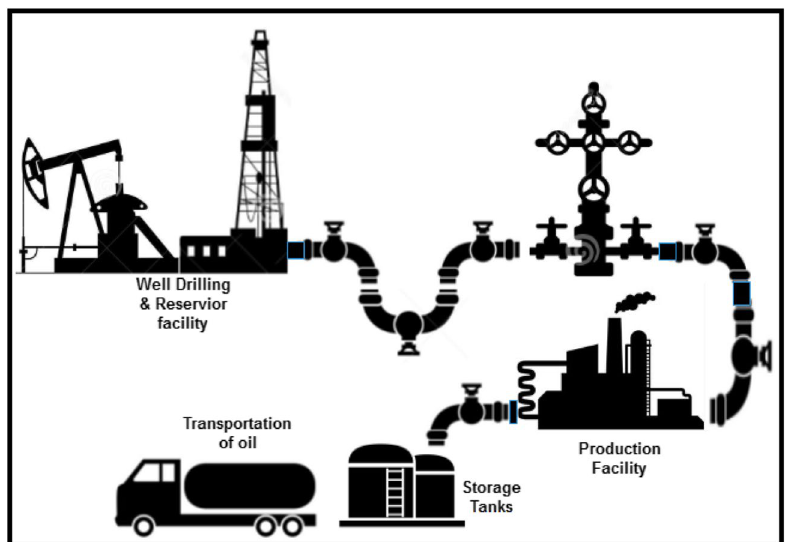
Fig. 1 The schematic of the oil processing